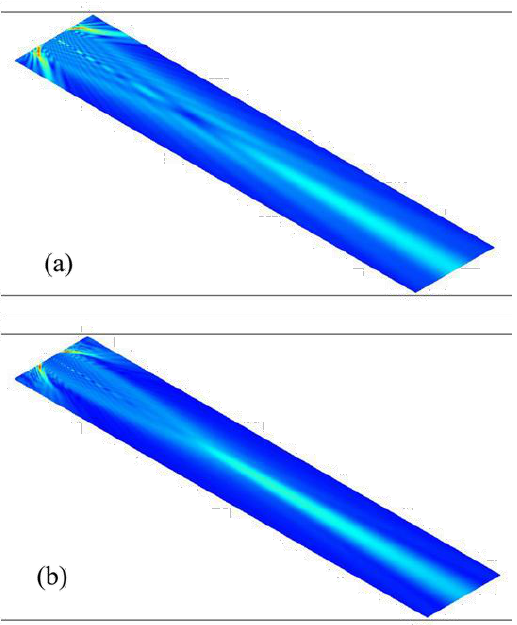
Figure 11. Pressure fields of the ( a ) plane (20 MHz) and ( b ) focusing (27 MHz) PMN-PT transducers